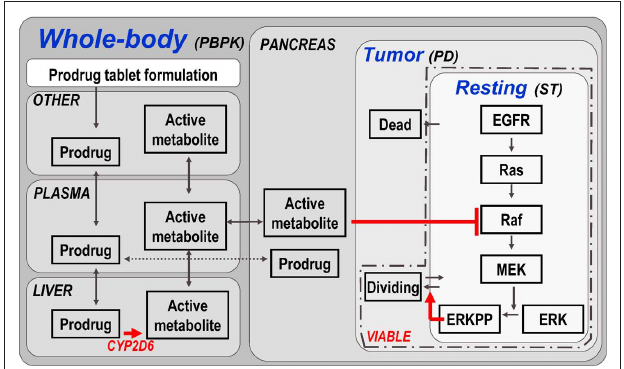
Figure 4 | Model structure of multiscale PBPK–PD–signal transduction (ST) application example. The figure outlines the most relevant processes captured in the multiscale model. Details (e.g., additional organs, sub- compartments, and proteins) are omitted for clarity. A whole-body PBPK model is constructed for a prodrug and its active metabolite. The two substances are coupled via a hepatic CYP2D6 clearance of the prodrug, which is the source for the active metabolite. A tumor (PD) model is contained in the pancreas of the whole-body model, considering resting, dividing, and dead cell populations. Within the resting cells an EGFR signal transduction model is nested. Raf, a kinase participating in the signal transduction process, is the target of the active metabolite. ERKPP, a transcription factor, drives the transition into the dividing population. The sum of resting and dividing cells constitutes the viable tumor mass and serves as a primary output. For additional details, see Materials and